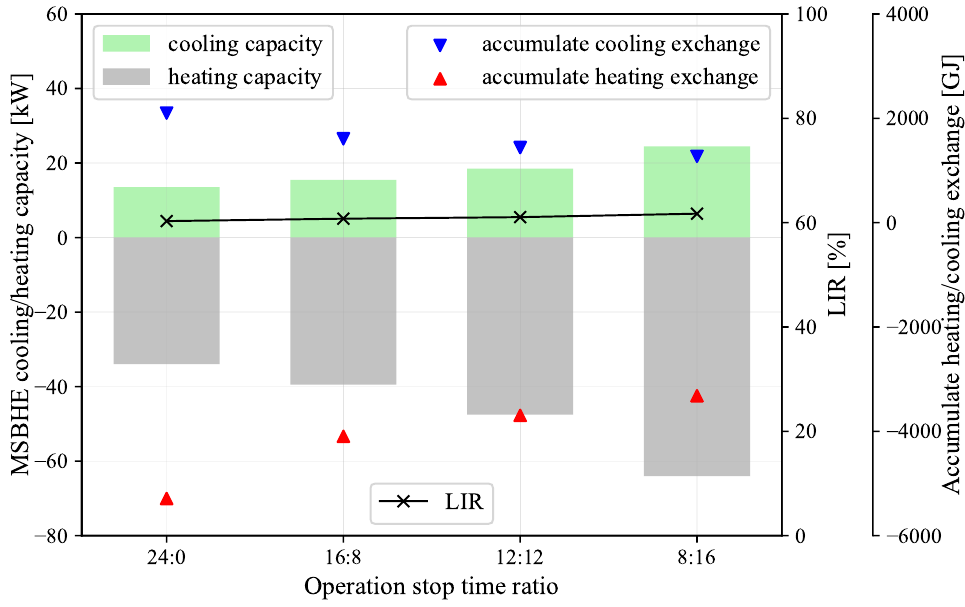
Figure 6. Maximum cooling and heating load of MSBHE and LIR under different model